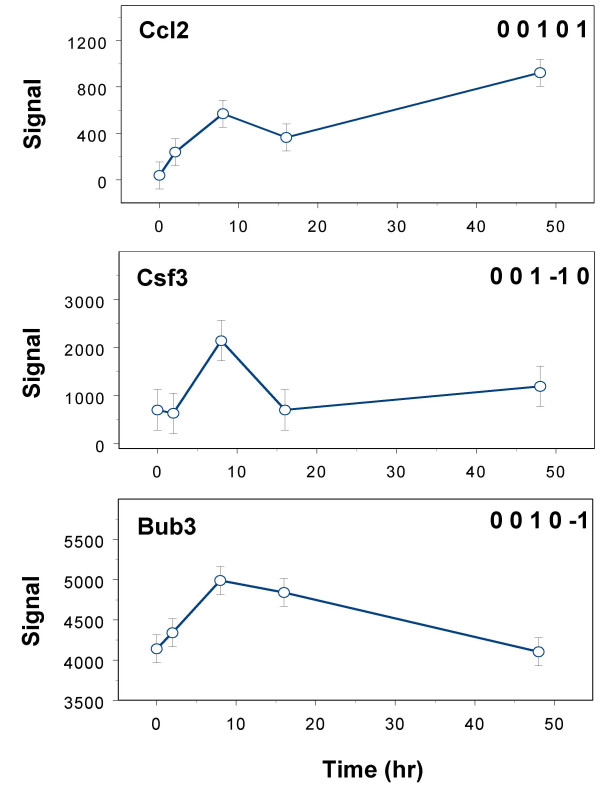
Example diagrams to illustrate expression patterns of genes in Class II. Expression patterns of genes Ccl2, Csf3, and Bub3 from Class II were significantly altered initially at 8 hr after OBX, and each of these genes has a different fluctuation index.